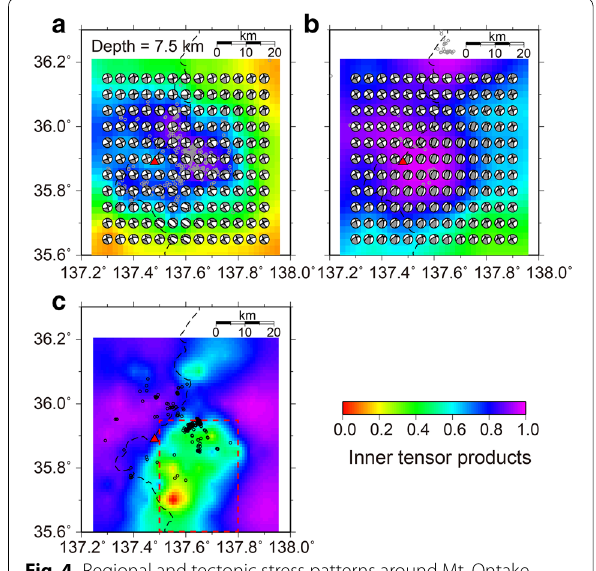
Fig. 4 Regional and tectonic stress patterns around Mt. Ontake. a Regional stress pattern inferred from focal mechanism solutions for May 2012 to July 2014 (Terakawa et al. 2016). b Tectonic stress pattern for the Ontake region (Terakawa and Matsu’ura 2010). The color scales in a , b denote the AVITP (“Estimation errors of the regional stress field around Mt. Ontake” section), which was used as the estimation error of the stress field. The gray open circles in a , b indicate the data that were used to infer the regional and tectonic stress fields, respectively. c Closeness of the regional and tectonic stress patterns measured with the inner tensor product between the two tensors. The black open circles denote the data used to estimate the pore-fluid pressures in “FMT analysis around Mt. Ontake” section. The dashed rectangle in red represents the region A, where the two stress patterns in a , b significantly